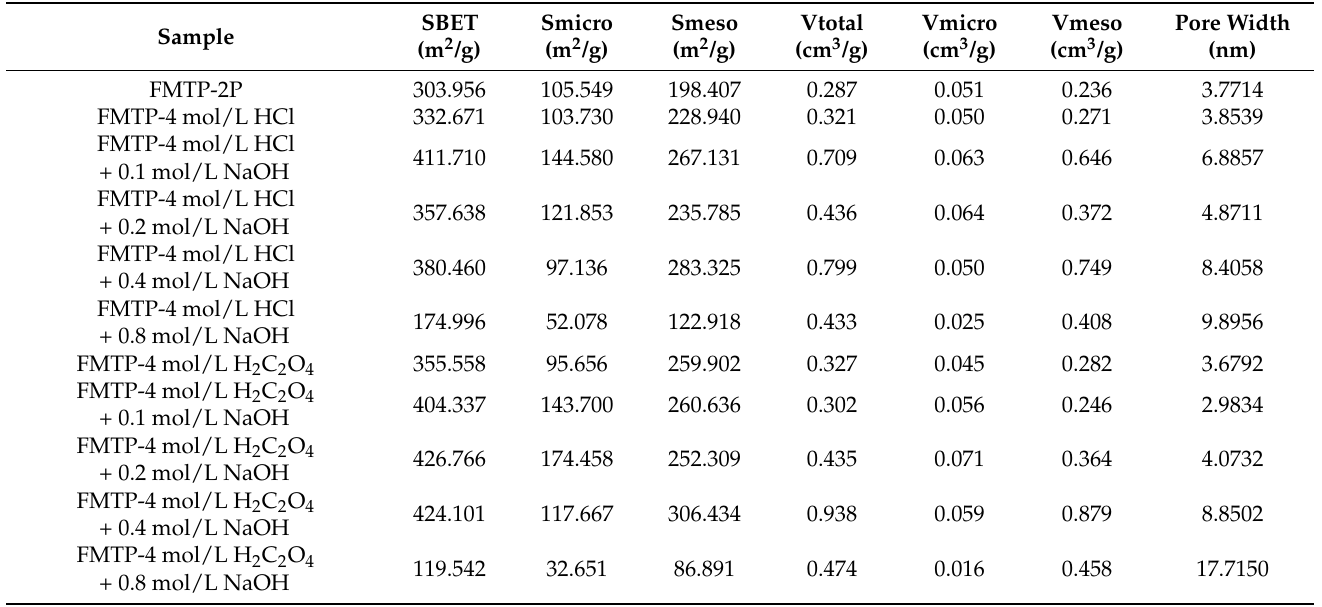
Table 3. BET-specific surface area and pore structure parameters of samples before and after acid and alkali combined treatment with 4 mol/L HCl and H 2 C 2 O 4